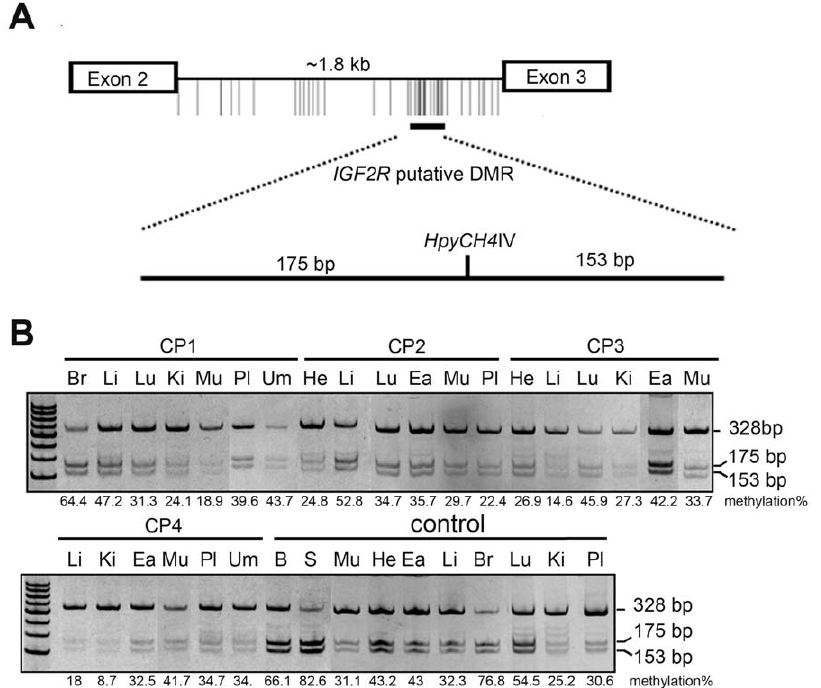
Figure 5. Methylation status of the IGF2R putative DMR of intron 2 in cloned pigs and wild-type pigs by COBRA analysis. (A) Schematic diagram showing the distribution of CpG sites of the pig IGF2R gene. (B) COBRA data showing the methylation status of the IGF2R intron 2 putative DMR in control and wild-type pigs. The numbers under the figure in the control panel indicate the average methylation percentage of three wild- type pigs. Br: brain;Ea: ear; He: heart;Ki: kidney;Li: liver; Lu: lung; Mu: muscle; Pl: placenta; Um: umbilical cord; B: blood; S: blood treated with Sss I; W: ddH 2 O.